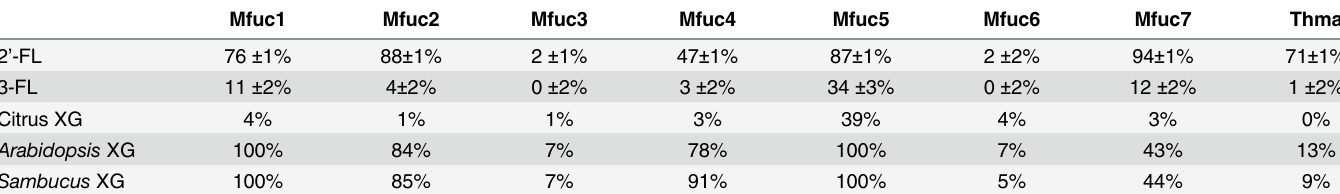
Table 3. Determination of regiospecificity and substrate specificity for hydrolysis of natural oligosaccharides and glycans.